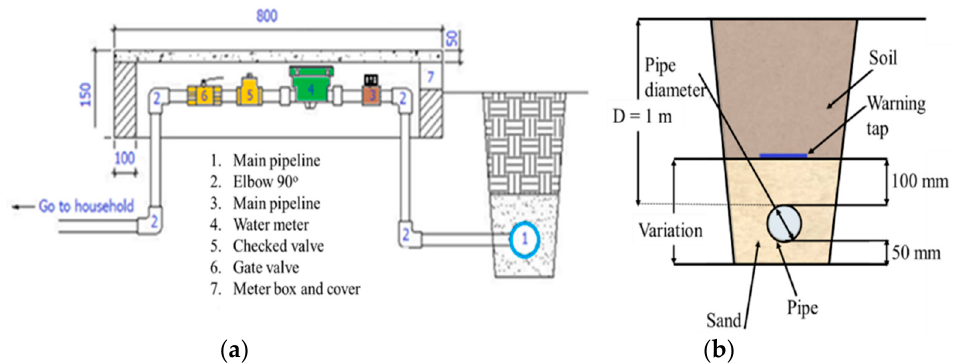
Figure A1. Requirements for ( a ) domestic water meter installation and ( b ) pipeline installation [26].